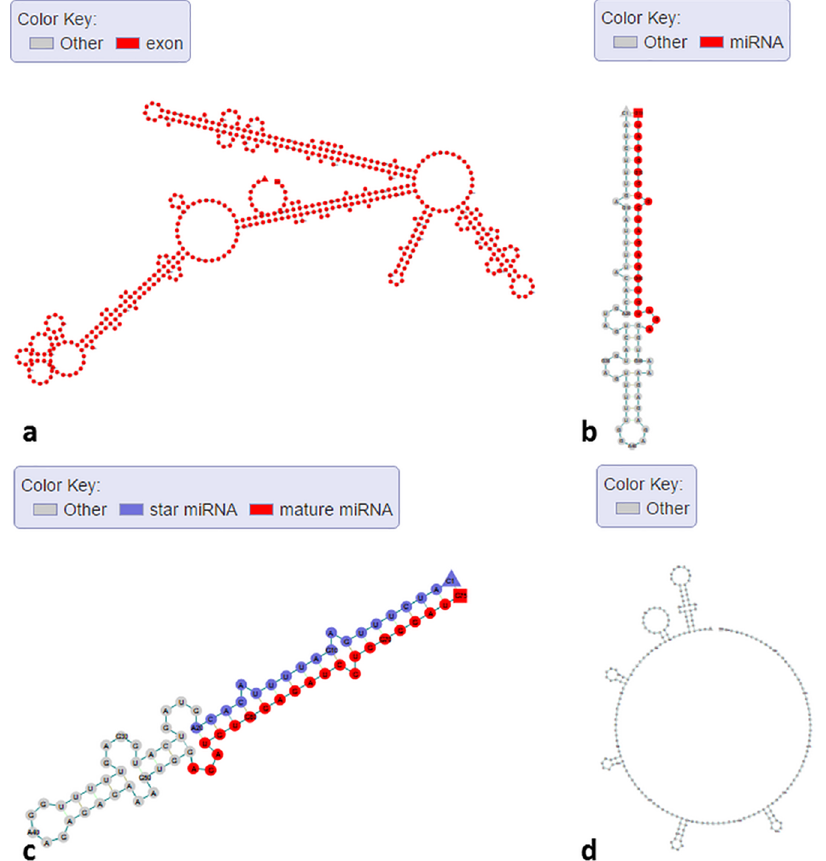
Fig 3. Secondary structure graphs of selected ncRNAs and ssDNAin Arabidopsis . (a) lncRNA (Ensembl ID “AT1G04425.1”). (b) miRNA (miRBase ID “MI0031741”). (c) miRNA (miRBase ID “MI0031741”) with customized annotationinformation (star miRNA position). (d) ssDNA (chromosome: 1; start: 200; end: 400; strand: +).